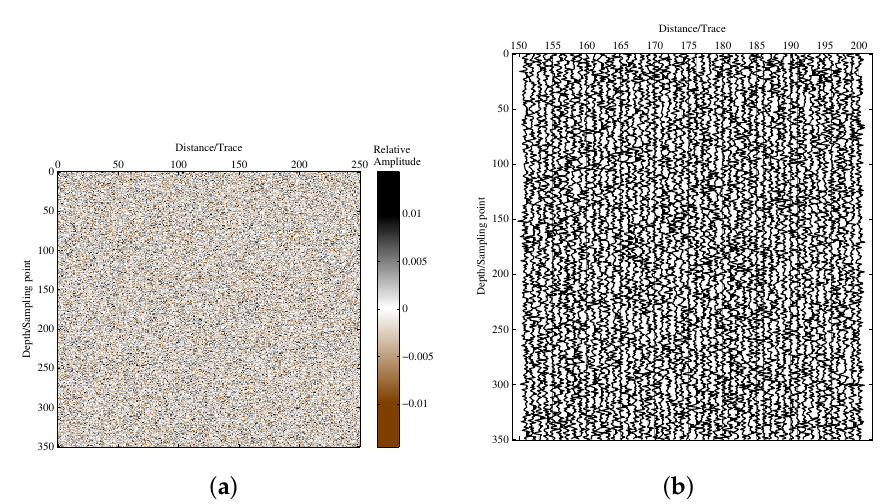
Figure 4. ( a ) Noise section; ( b ) Waveforms of noise added to traces 151 to 200.